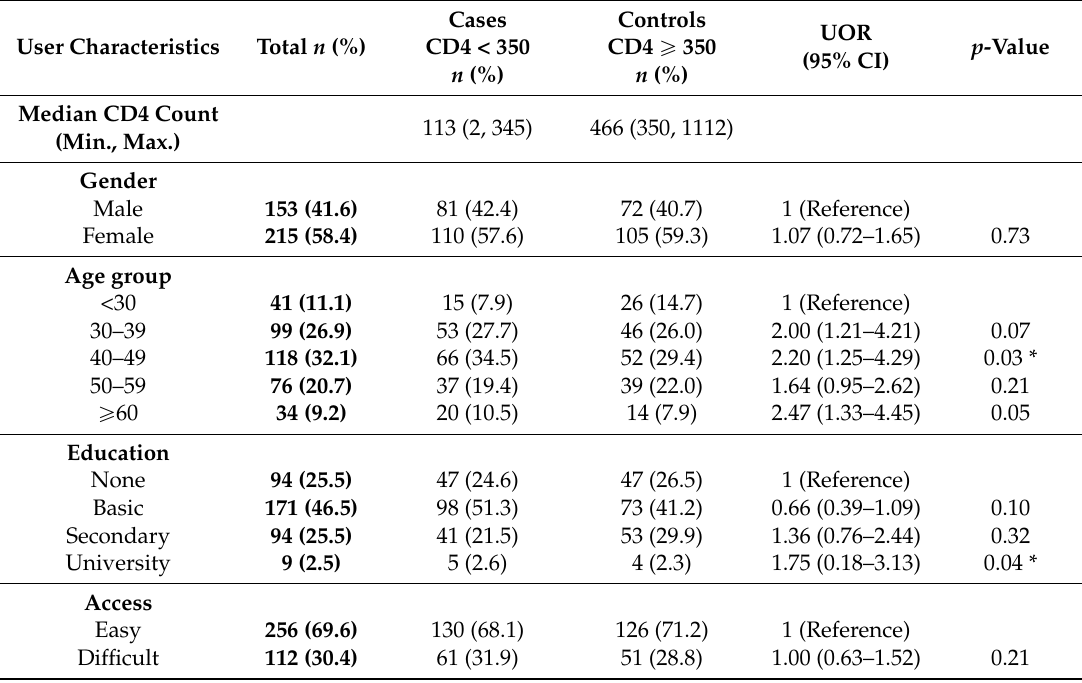
Table 2. Sociodemographic characteristics of study participants and factors associated with